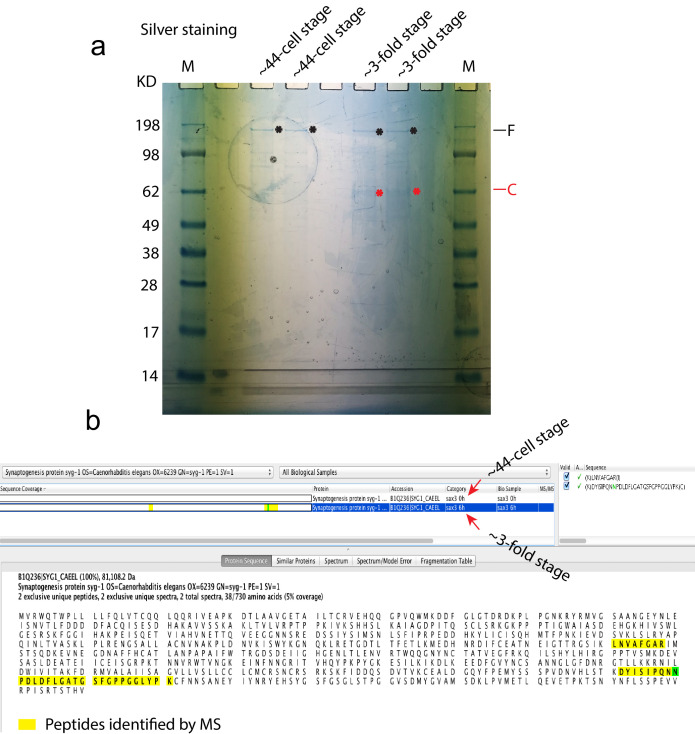
Identification of SAX-3 interacting proteins by proteomics.(a) A image from silver staining shows the full length (black stars) and cleaved fragment (red stars) of SAX-3. These samples were then submitted for proteomics. (b) A screenshot of the Scaffold software that shows that SYG-1 was identified with specific interactions with SYG-1 in threefold but not in 44-cell stage embryos. The green color of the asparagine(N) means that this amino acid was deamidated to either aspartic acid or isoaspartic acid.